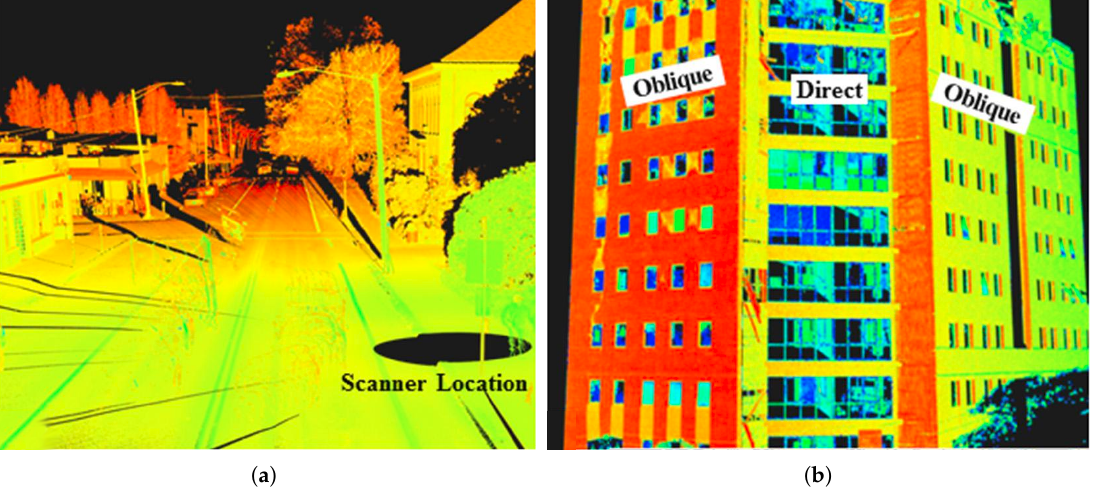
Figure 5. The dependency of laser intensity readings (weak readings in red, strong in green) on the measurement range ( a ) and the angle of incidence ( b )